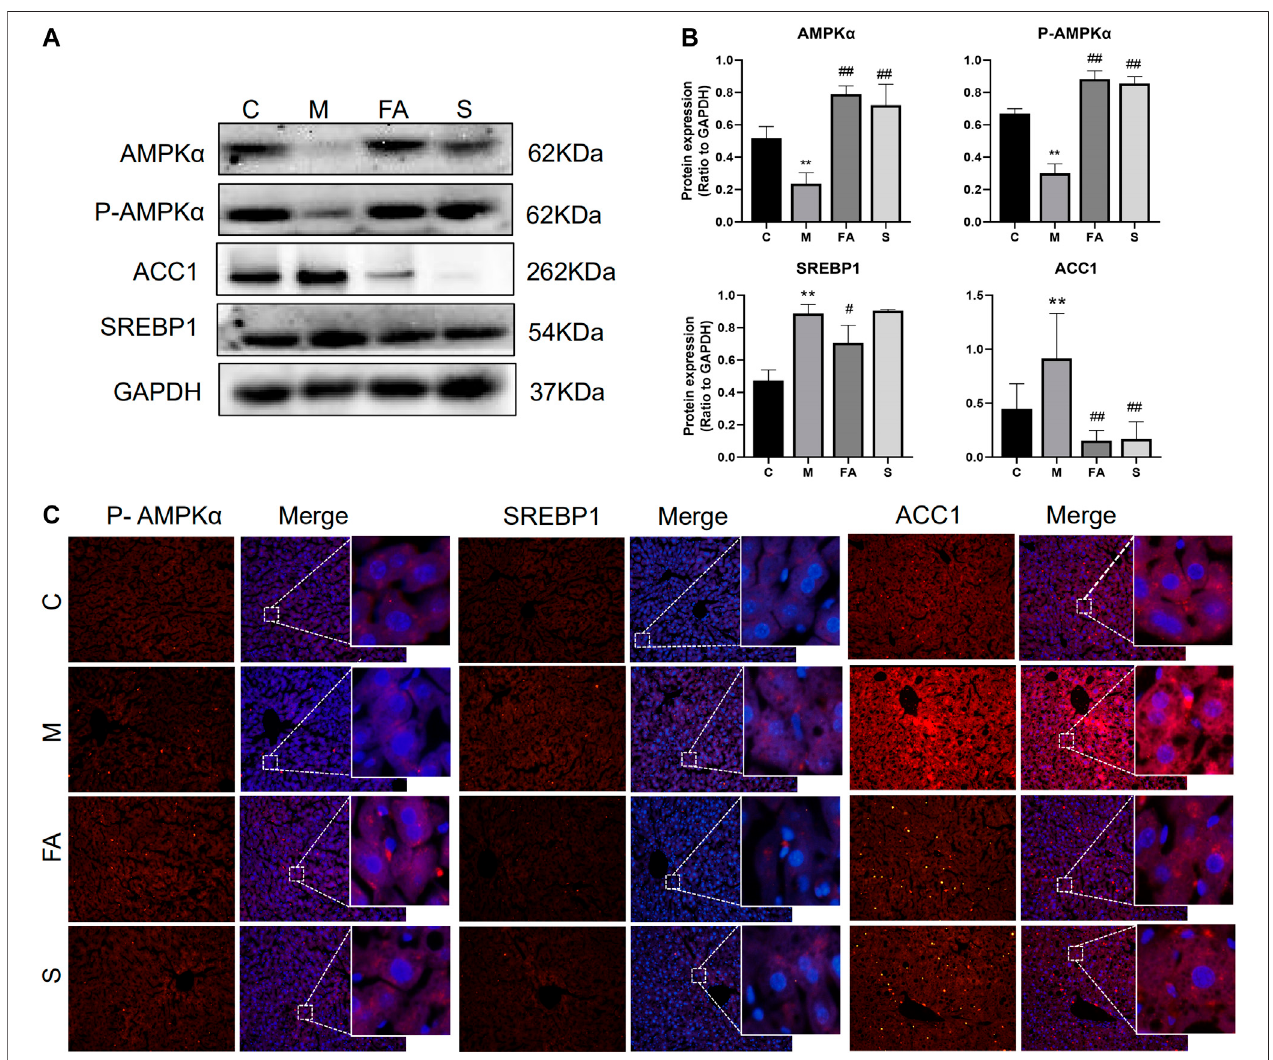
FIGURE5 | FA regulated theexpression oflipid metabolites-related Proteinsin HFD-fed ApoE − / − mice (A), (B) Protein expression of AMPK α , P-AMPK α ,SREBP1, ACC1inliver( n (cid:2) 3), (C) inmmuno fl uorescencestainingofACC1,SREBP1inLiversections(200 × ).* p < 0.05;ascomparedtothecontrolgroup. # p < 0.05, ## p < 0.01;as compared to the model